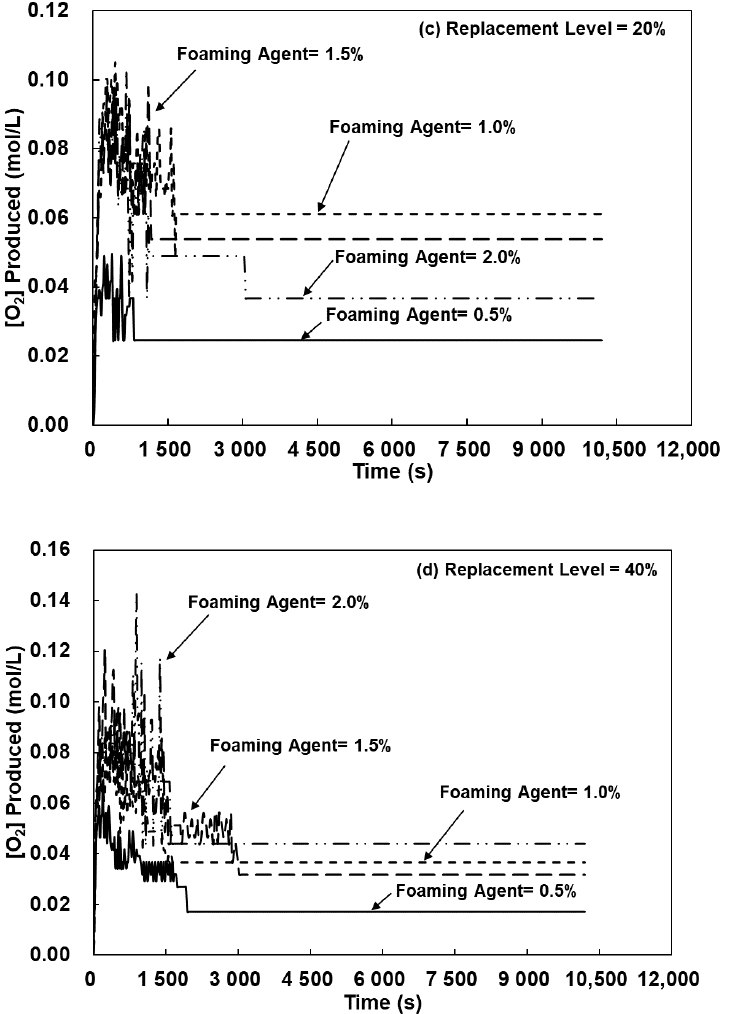
Figure 10. The amount of O 2 produced for the lightweight FGPs with SCS replacement levels. ( a ) 0%; ( b ) 10%; ( c ) 20% and ( d ) 40%